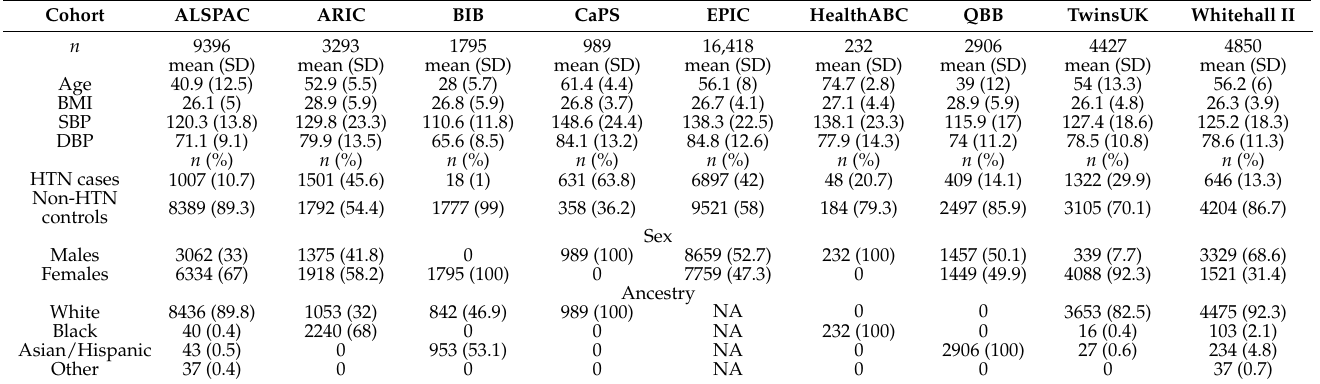
Table 1. Descriptive characteristics of included cohorts.